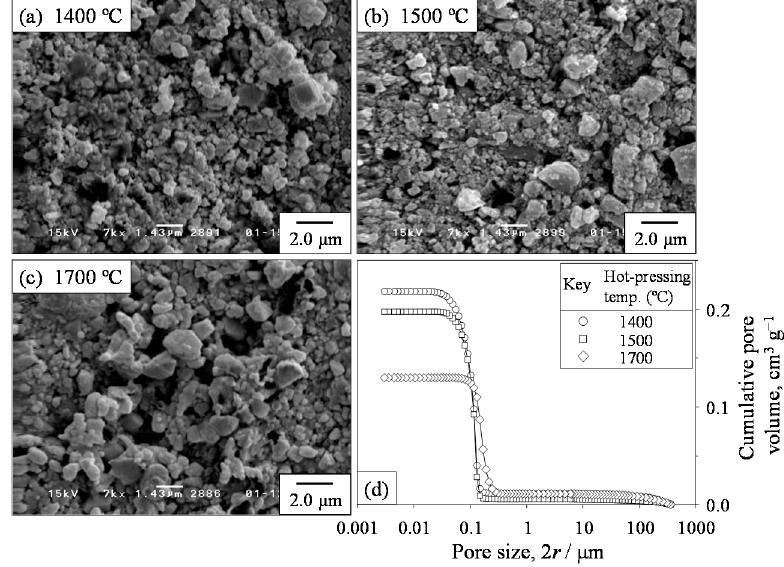
Figure 5. ( a – c ) Microstructures and ( d ) pore size distributions of SiC ceramics hot-pressed at ( a ) 1400 °C; ( b ) 1500 °C; and ( c ) 1700 °C.